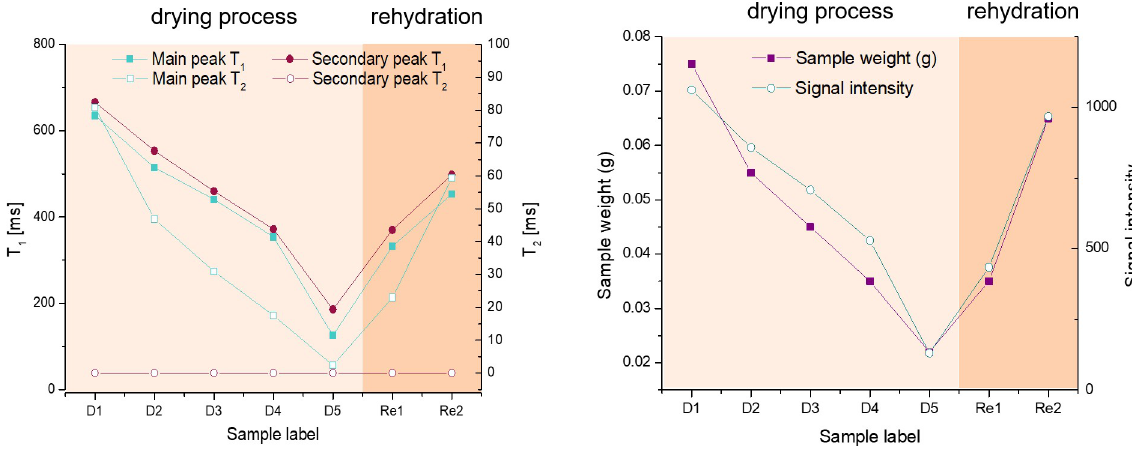
Fig 4. (left) Evolution of 1 H T 1 and T 2 values for both peaks over the whole range of the experiment. The left Y axis represents the T 1 values, the right Y axis represents the T 2 values. The values of the secondary peak T 2 are almost constant at about 20 μ s. (right) Evolution of sample weight and signal intensity (data from Table